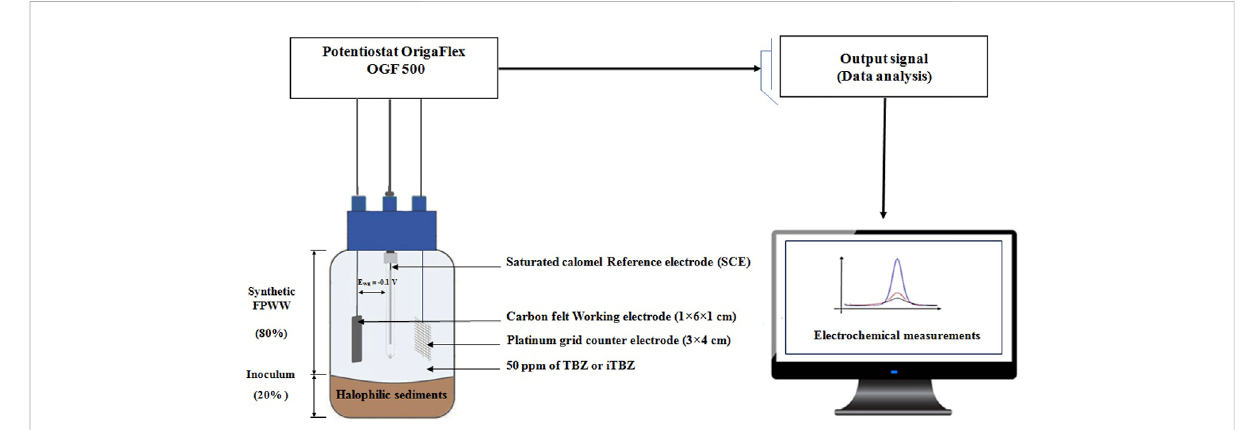
FIGURE 1 Schematic representation of microbial electrolysis cell (MEC) and bioelectrochemical